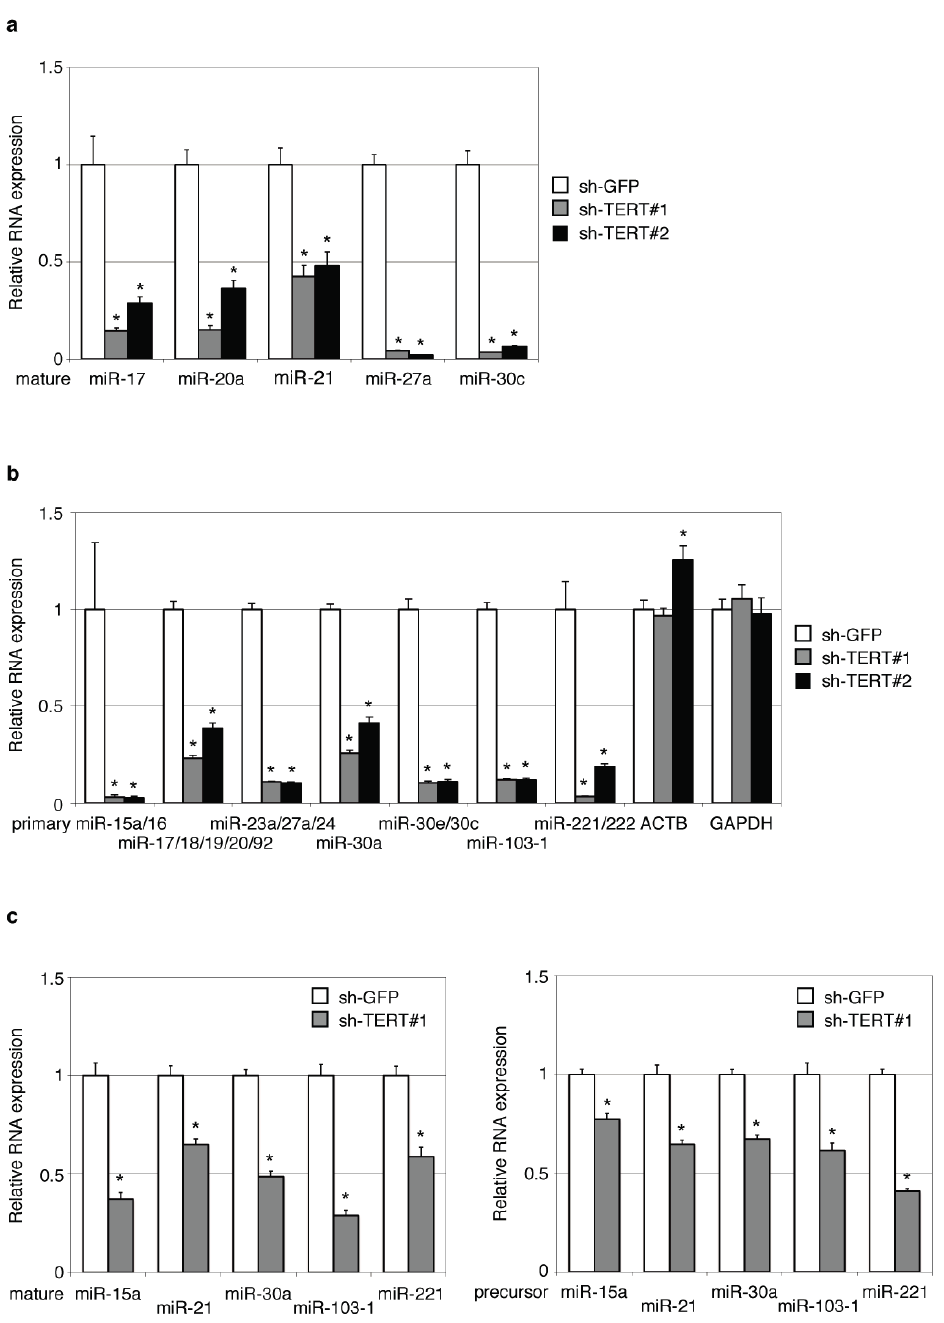
Figure 2. Mature miRNAs and their precursors are downregulated upon TERT suppression. The expression levels of primary, precursor and mature miRNAs in HeLa cells were analyzed with RT-qPCR under the suppression of TERT by sh-TERT#1 (gray) or sh-TERT#2 (black). The relative amount of the individual miRNAs was normalized to U6 , and the mean expression levels of normalized sh-GFP (white) refer to one. ( a , b ) RT-qPCR of mature ( a ) and primary ( b ) miRNAs performed with total RNAs. The mRNA levels of ACTB and GAPDH were also examined with the same total RNAs; ( c ) RNAs smaller than 200 nt were used for RT-qPCR of mature ( left ) and precursor ( right ) miRNAs. Values represent the means ± SD for three independent experiments. Asterisks represent p < 0.05 compared with